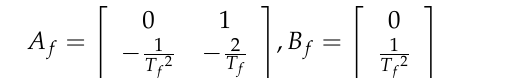
Figure 5. Angle velocity state estimation of state observer. 4.2. Collision Avoidance Simulation Result To show the performance of the controller of collision avoidance, we used the RBF neural network to estimate the unknown disturbance. Figure 6 shows that the UUVs fol- low the desired trajectory well and keep a good formation form. The distance between any two UUVs is more clear to show the collision. The 2 c r line is set at the bottom of Figure 7. If the distance 2 ij c d r  , collision occurs. Figure 7 shows the distance between any two UUVs of the formation considering collision avoidance. There is no line under the 2 c r line. The distance between UUVs is below to 2 c r . With the collision avoidance control, the formation performance can be guaranteed.